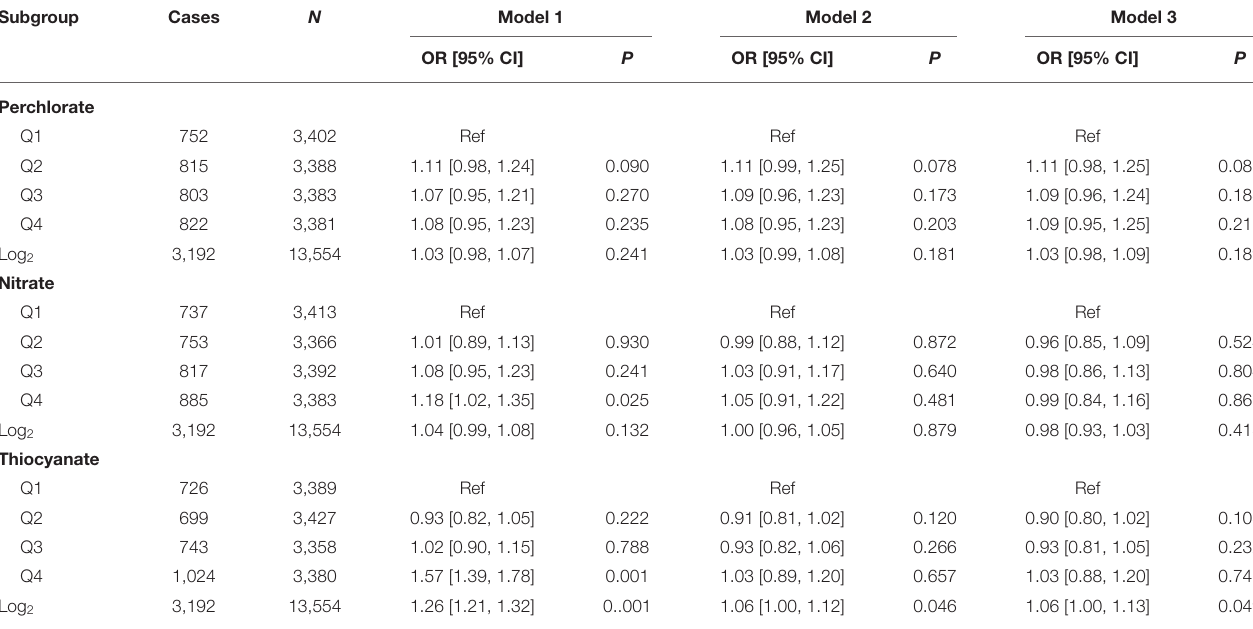
TABLE 2 | Association of urinary perchlorate, nitrate, and thiocyanate with the presence of oral pain. Subgroup